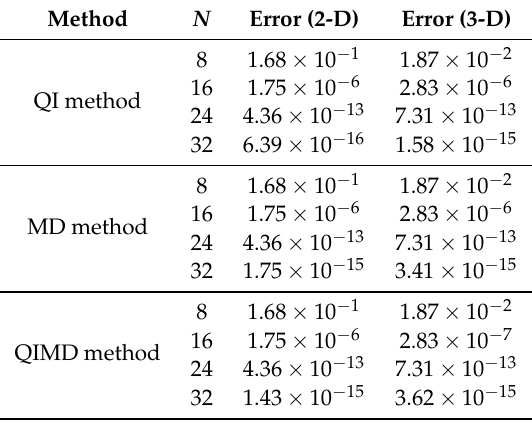
Table 1. Errors of numerical solutions of 2-D and 3-D Poisson equations as a function of unknowns in 1-D. The numerical solutions are computed using QI, MD, and OIMD methods where QI, MD, and QIMD stand for Quasi-Inverse, Matrix Diagonalization, and Quasi-Inverse Matrix Diagonalization, respectively. All methods show a similar order of accuracy and reach spectral accuracy at N =